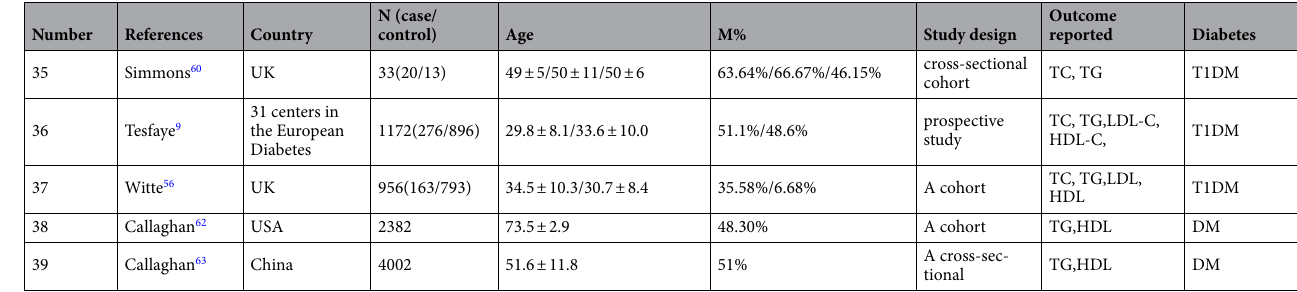
Table 1. Studies included in the meta-analysis.